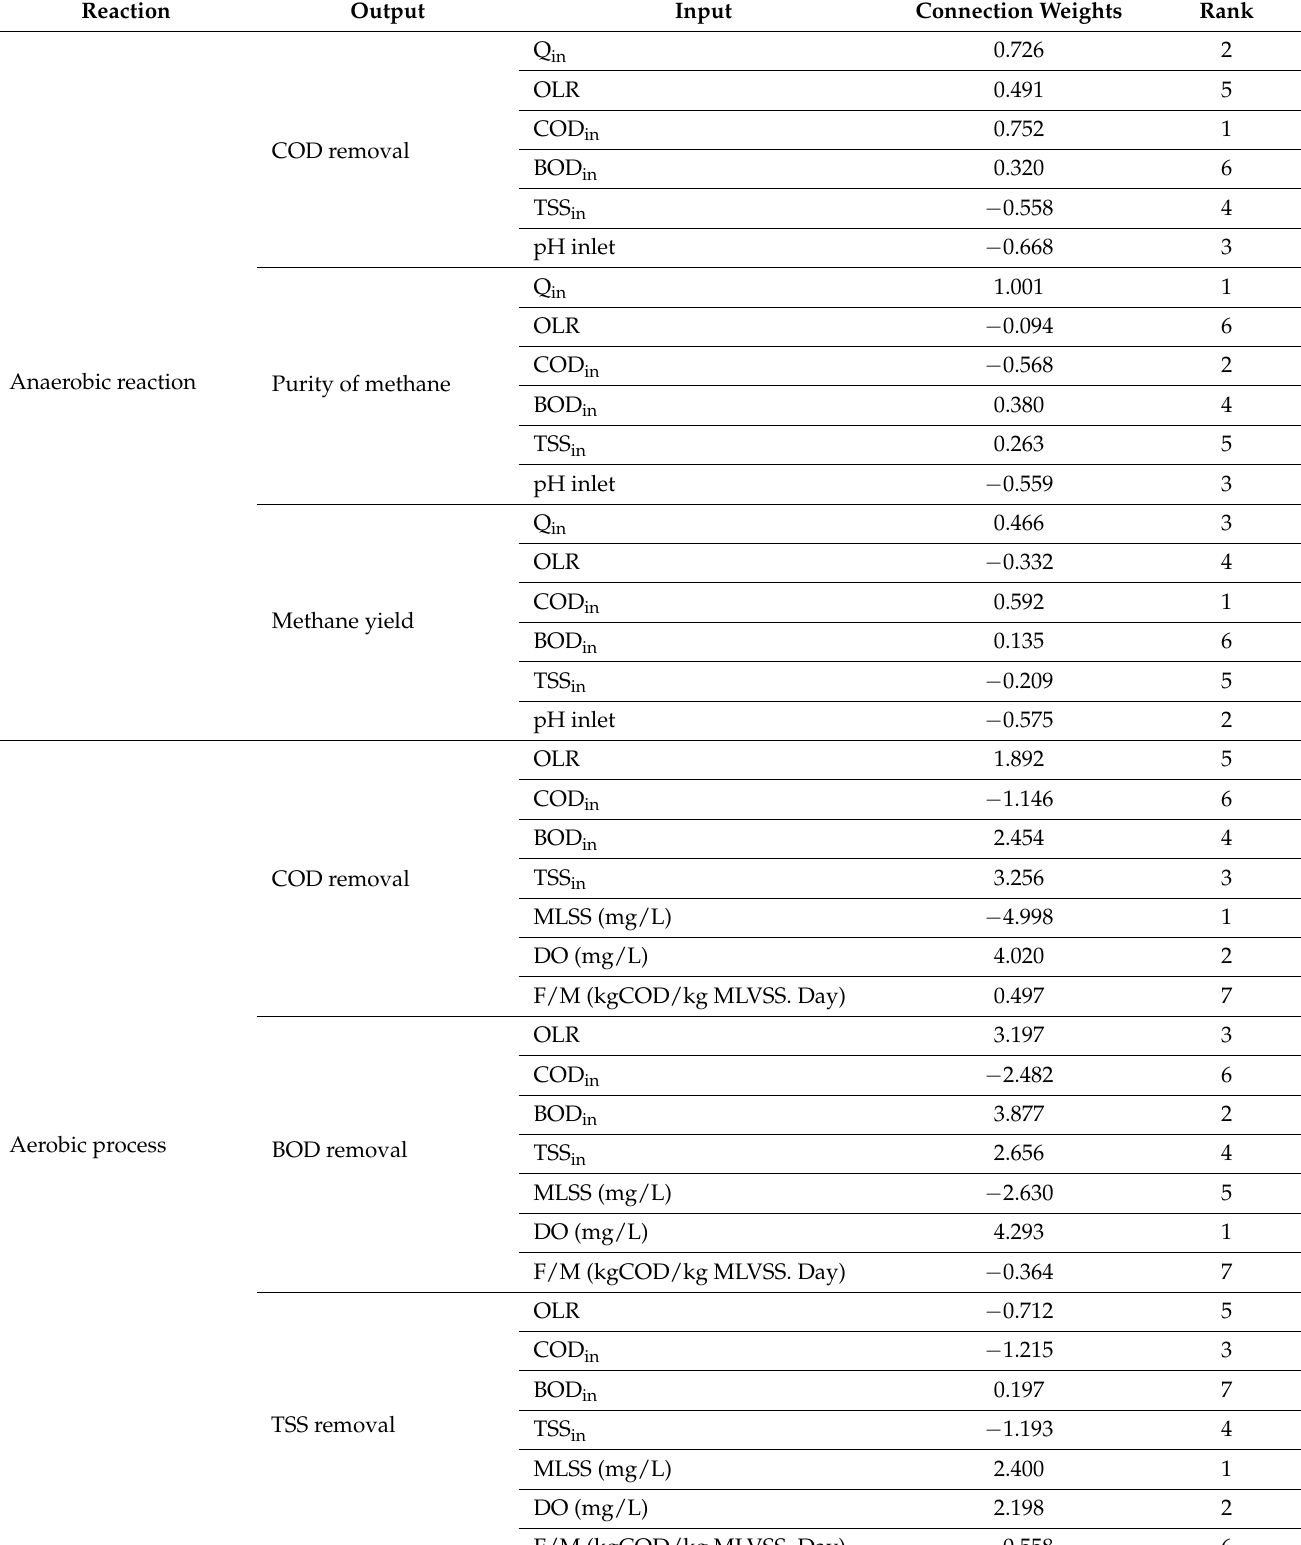
Table 2. Influence of input factors on anaerobic process using connection weight